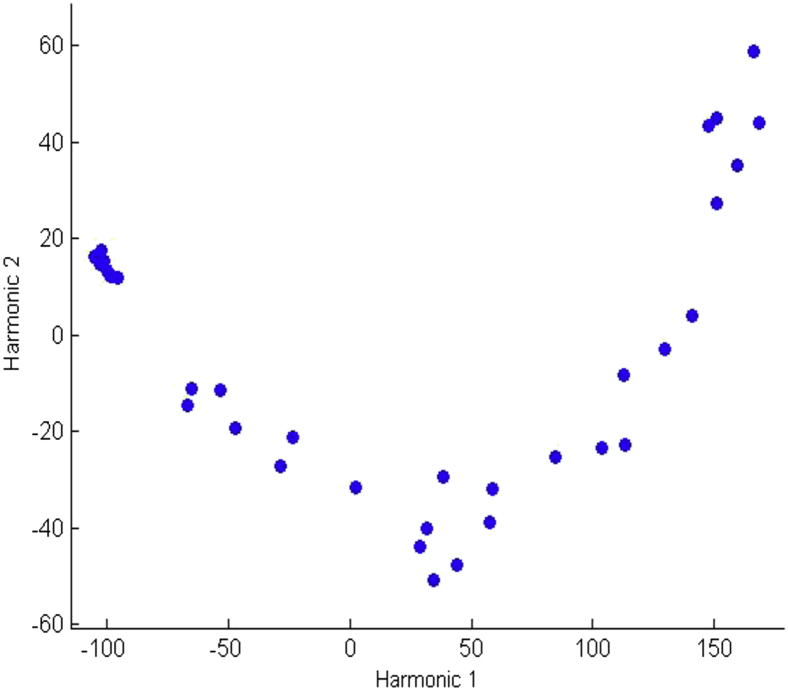
Scores of patients on the first 2 principal components of the allergic response.